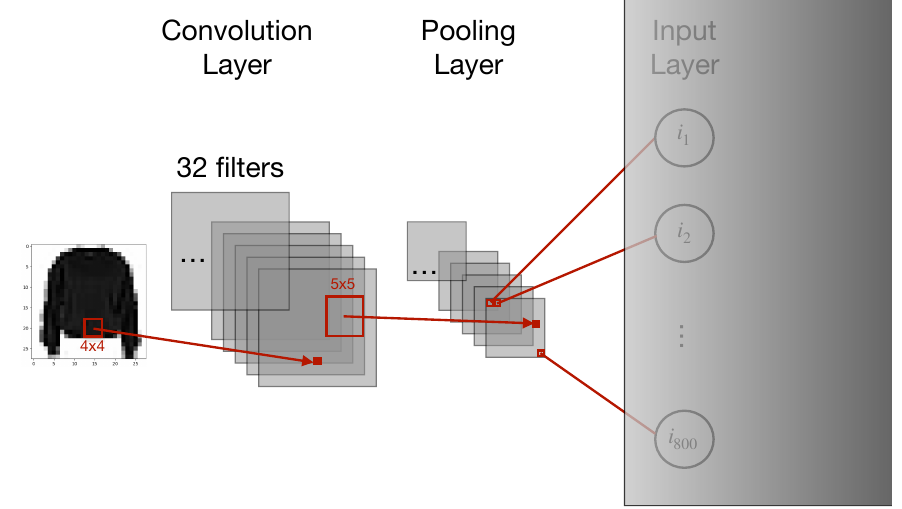
Figure 4. Convolutional neural network scheme. The number of parameters in this particular network is 544 plus the number of parameters of the FdNN following the convolutional layers. The CNN uses Fashion MNIST images of size 28 × 28 as input and applies 32 filters of size 4 × 4 requiring 544 weights (32 × 4 × 4 + 32 = 544, note that there is a bias term in each filter). At this point, it has 25 × 25 × 32 = 20,000 values to deal with the information obtained after the processing employing the 32 filters. After the convolution, a pooling layer of 5 × 5 (which do not require additional parameters) is used, reducing the size of the input data significantly, precisely to 800. Finally, it outputs 800 data as input for the first layer of the fully dense